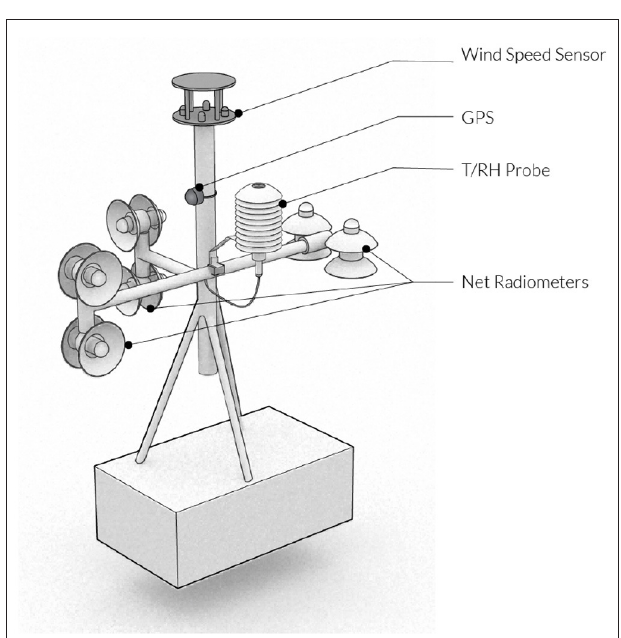
FIGURE 2 | The MaRTy cart sensor platform.